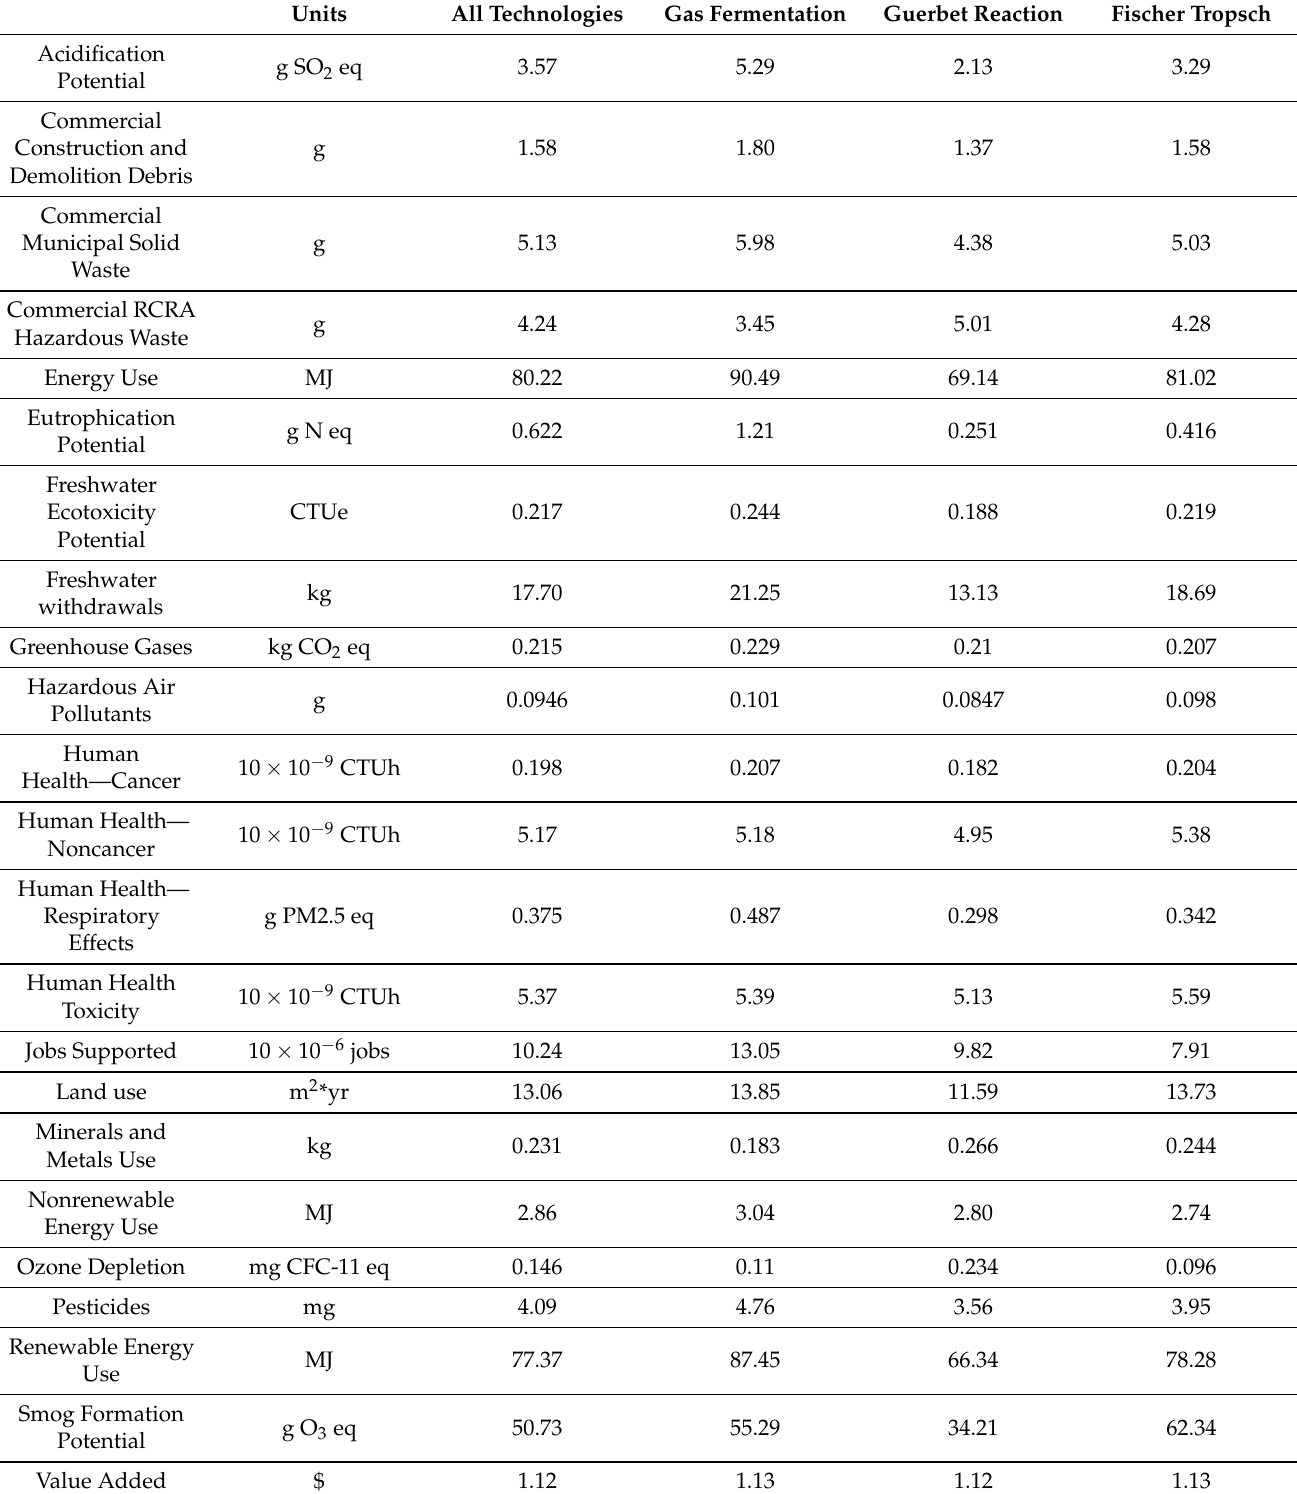
Table A6. Biofuels impacts per GGE with 3.68%